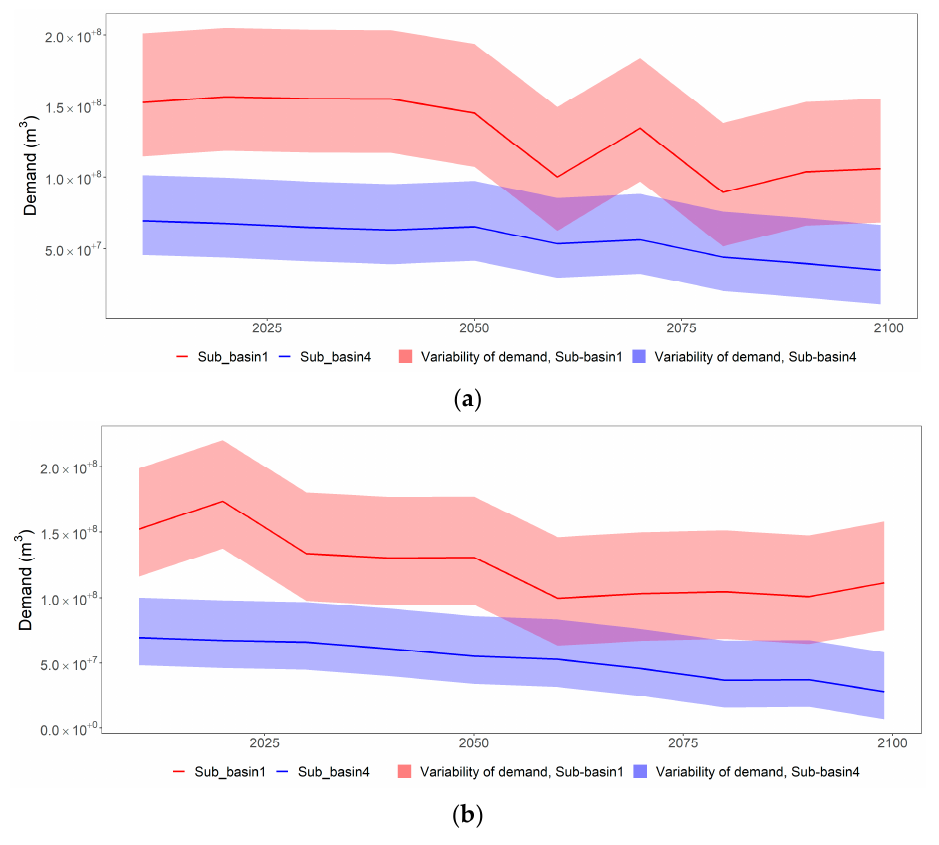
Figure 10. Estimated agricultural demands for ( a ) Scenario 1 and ( b ) Scenario 2 (2020–2099). Table 9. Future agricultural demand.